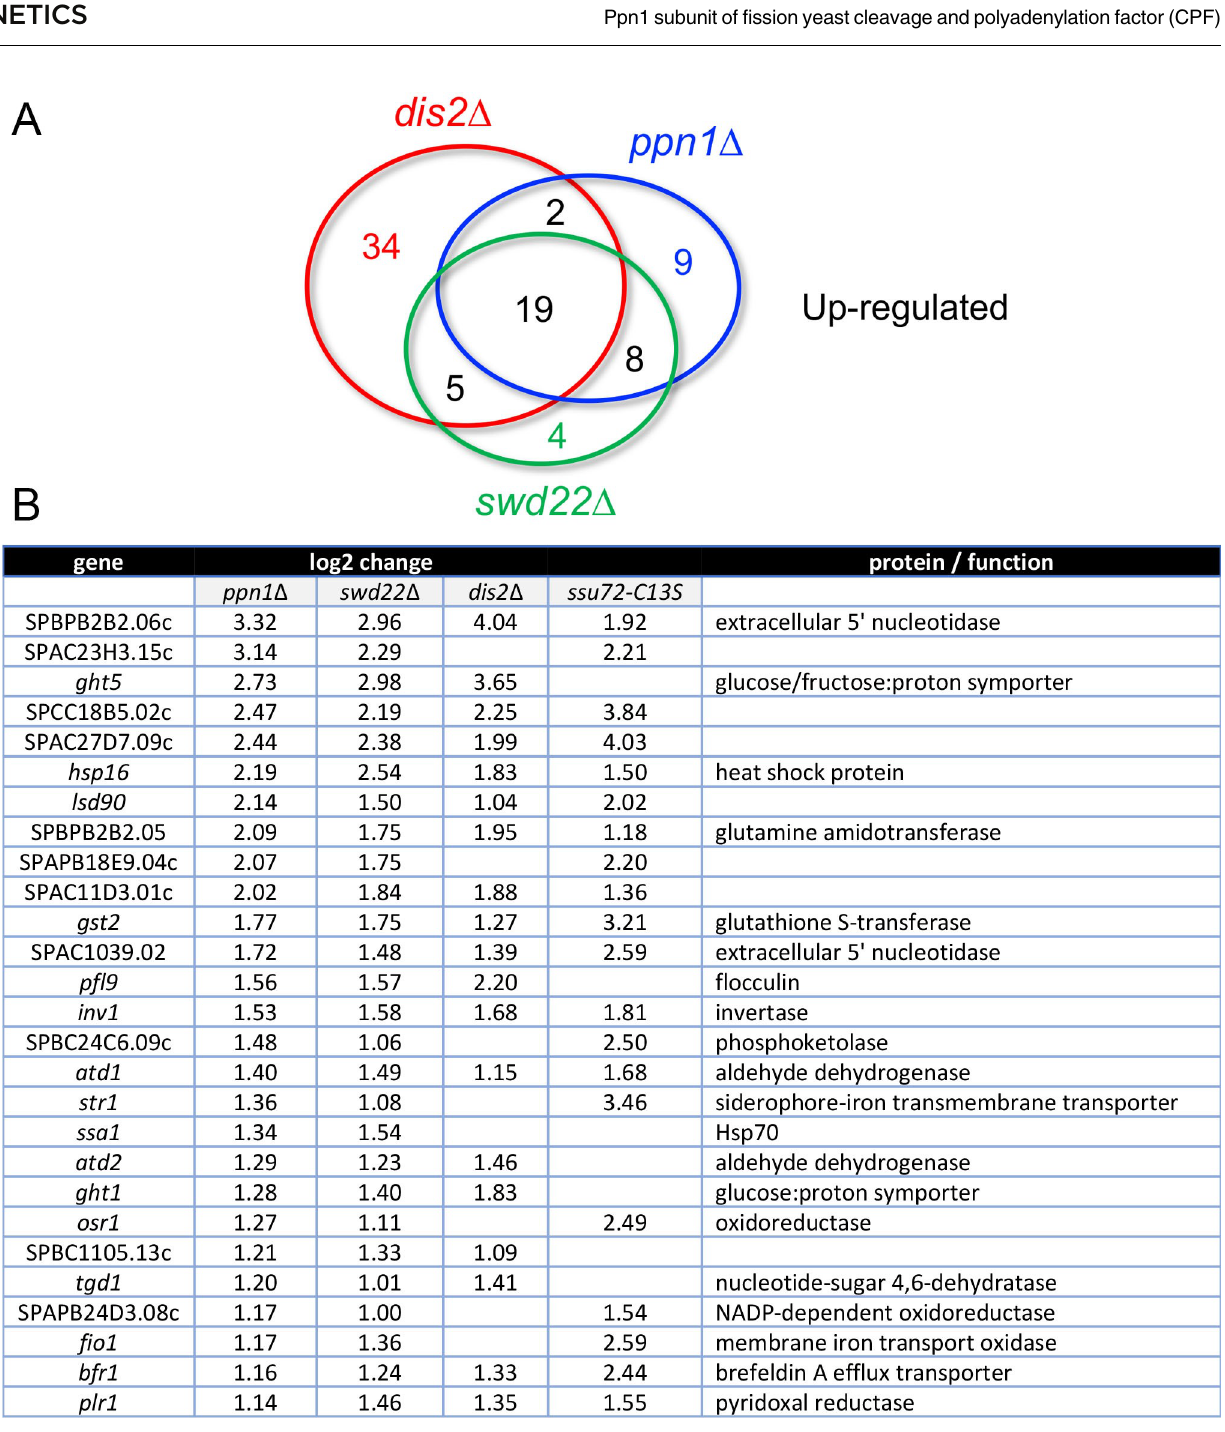
Fig 2. Coding genes up-regulated in DPS mutants. (A) Venn diagram depicting numbers of overlapping and non-overlapping up-regulated protein- coding genes. (B) List of 27 protein-coding genes that were coordinately up-regulated at least 2-fold in ppn1 Δ and swd22 Δ cells, 19 of which were also up- regulated in dis2 Δ cells and 20 of which were up-regulated in s su72-C13S cells. The log2 fold changes versus wild-type are